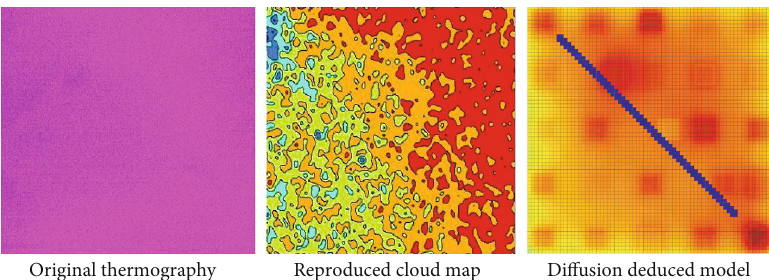
Figure 11: Comparison of original infrared map and the di ff usion deduced model at peak stress ( t = 1014 : 32s ) under 14